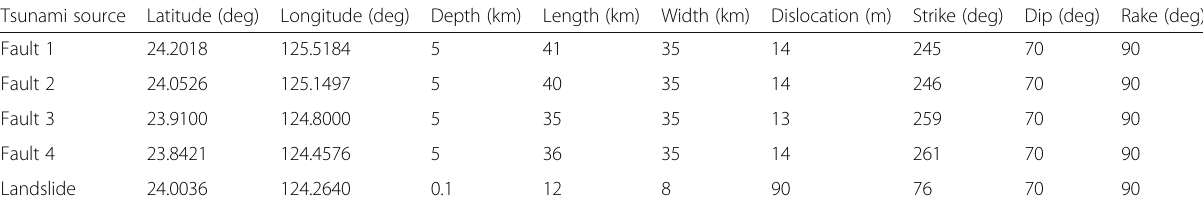
Table 2 A fault model used for this